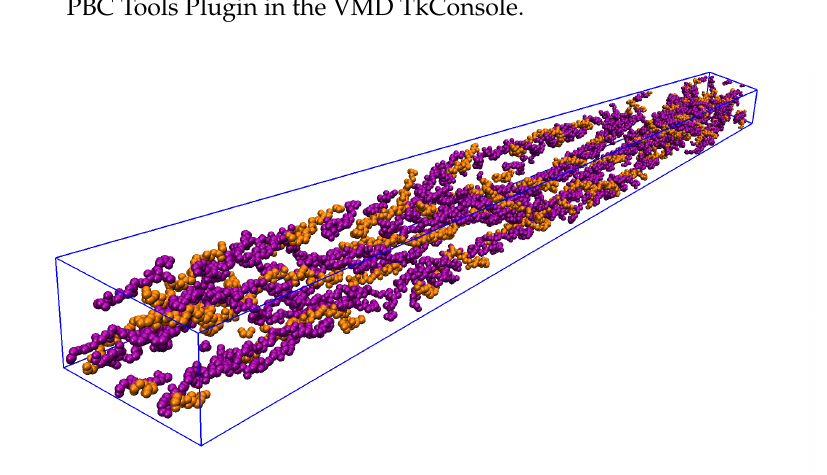
Figure 3. CLG Fibril within UC; snapshot from VMD viewer.